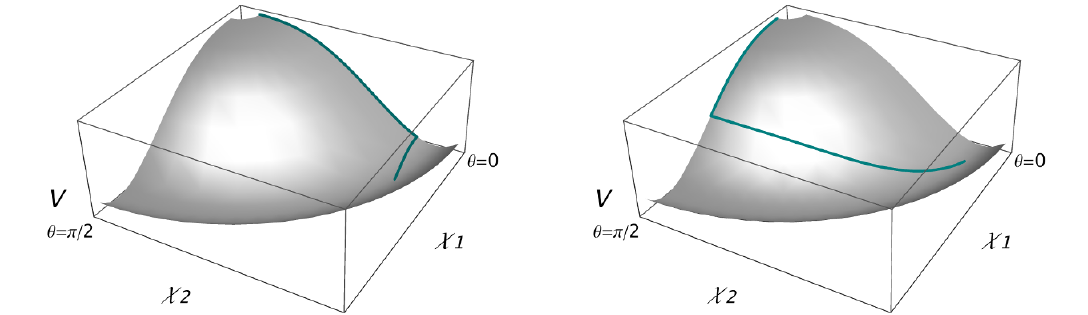
Figure 4 . Same as in (cid:12)gure 3 but in canonical variables (cid:31) 1 ; 2